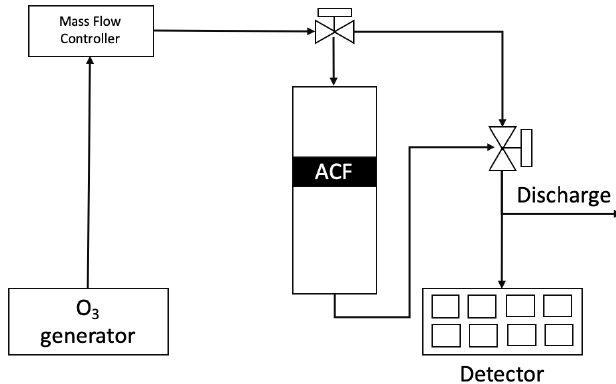
Figure 2. Reactor process flow diagram for surface treatment using ozone.